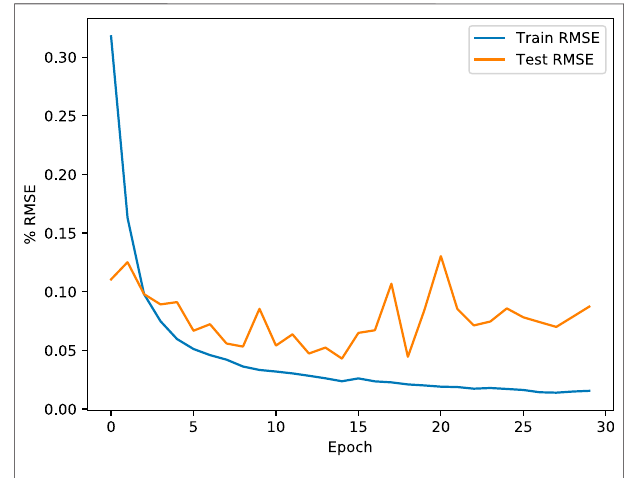
FIGURE 9 | Root mean squared deviation between the train and test subsets during successive training epochs. While the training RMSE continually decreases, suggesting improvement, the test RMSE begins to increase after 20 epochs, suggesting that the solution is being over fi t.